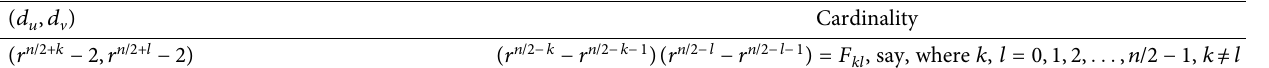
Table 6: Partition of pair of nodes ( u,v ) having distance 1.